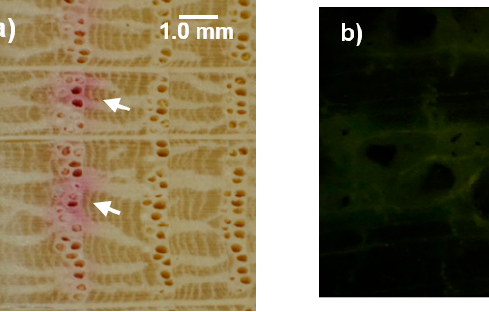
Figure 5. Micrographs of xylem for the dye injection experiment. ( a ) A part of a cross ‐ sectional disc at 0.5 m from the dye injection site. The arrow shows stained large ‐ diameter outermost vessels. ( b ) The outermost vessels in a radiation cross ‐ sectional face. The arrow shows the fluorescent dye in the vessel lumen. ( c ) The outermost vessels in a cross ‐ sectional face. The arrow shows the fluorescent dye in the vessel lumen and the annual ring boundary. L = large vessel. S = small vessel.